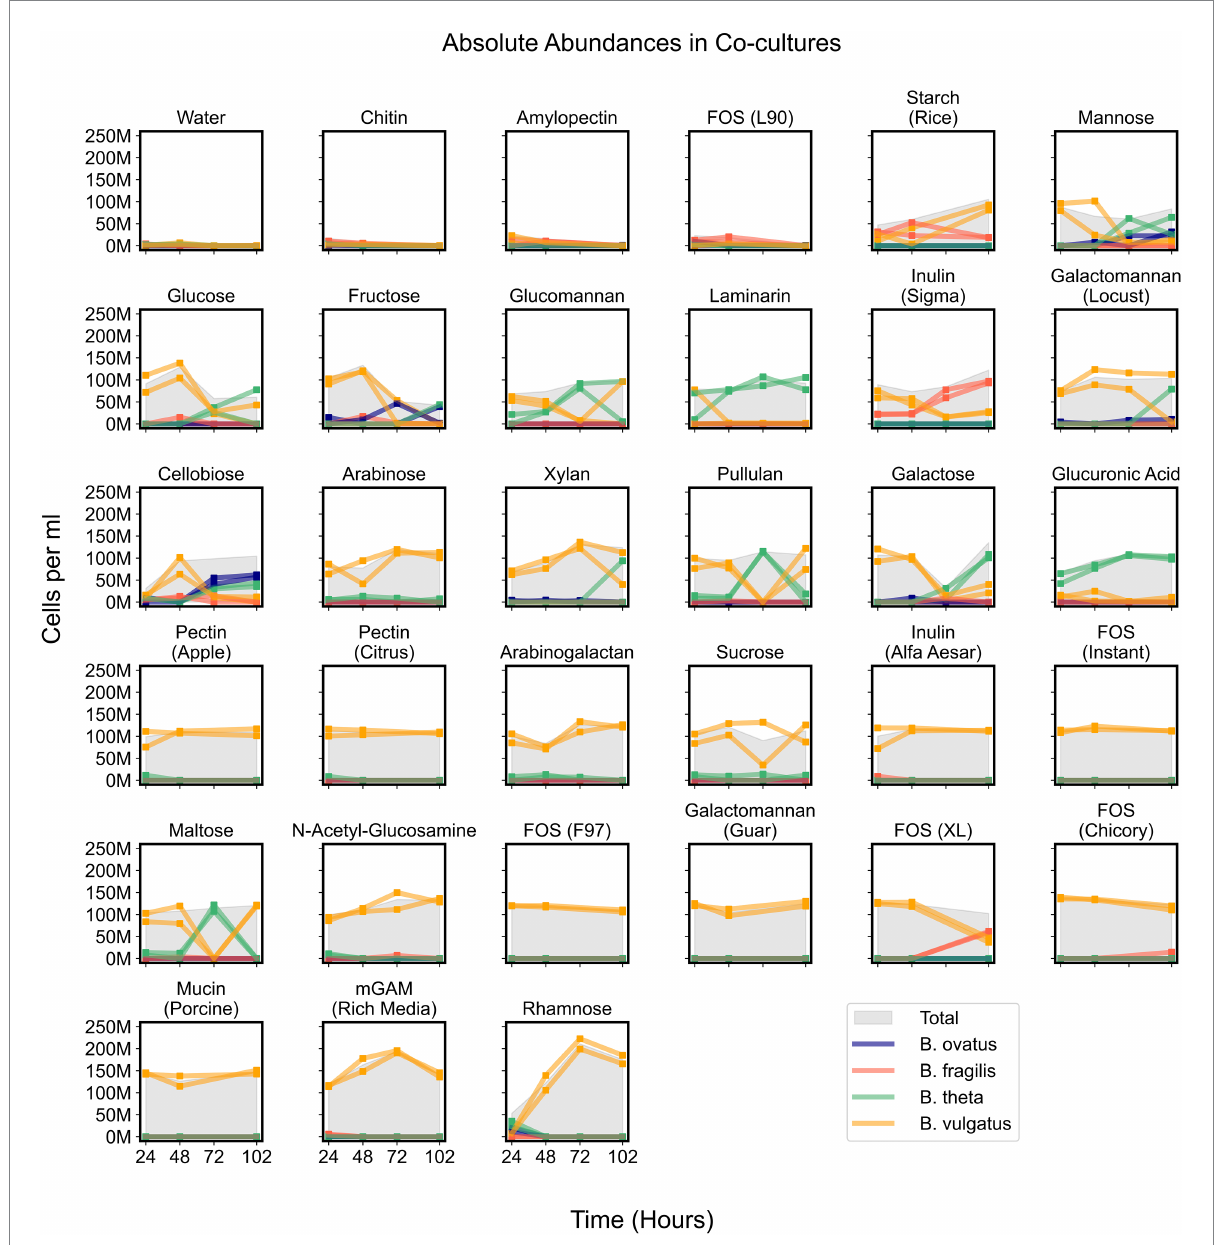
FIGURE 5 Absolute abundances of Bacteroides species in co-cultures on minimal media supplemented with single carbon substrates. Growth curves display absolute abundance of each species at each time point in 34 tested media. Plots include co-cultures on minimal media without a carbon source (Water) as a negative control and co-cultures on rich media (mGAM) as a positive control. “M” indicates values in the millions. Parentheses in titles indicate either the vendor source (e.g., Sigma or Alfa Aesar), organic source (e.g., starch from rice), or proprietary name (e.g., fructooligo saccharides L90). “Total” corresponds to the cumulative concentration (cells per ml) of all species in each sample. Square markers indicate actual measurements which are connected by lines and each line corresponds to a unique experimental replicate. Bo, Bacteroides ovatus ; Bf, Bacteroides fragilis ; Bt, Bacteroides theta ; Bv, Bacteroides vulgatus